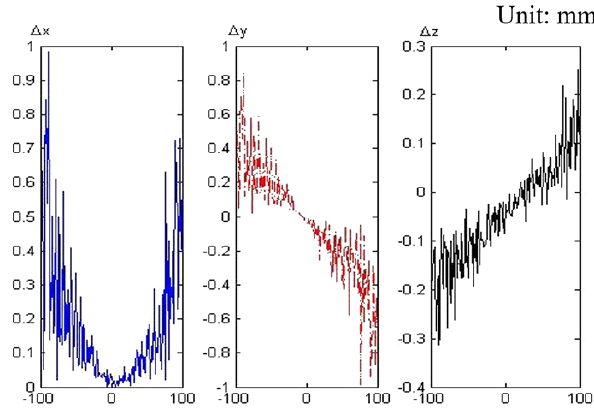
Figure 12. Position error caused by the attitude error when y = 0, z = 1000mm and X = ( − 100 ,